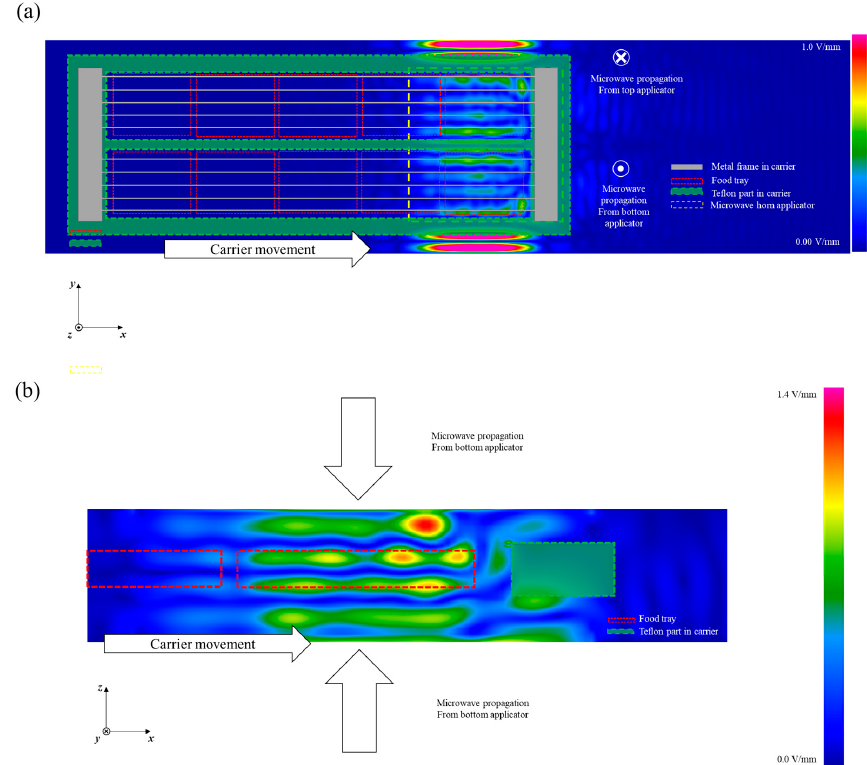
Figure 4. Time average electric field in the cavity of the MATS system when the edge of the food transport carrier is located at the center of the cavity. ( a ) x–y plane, ( b ) x–z plane (scales are adjusted for better electric field visualization).